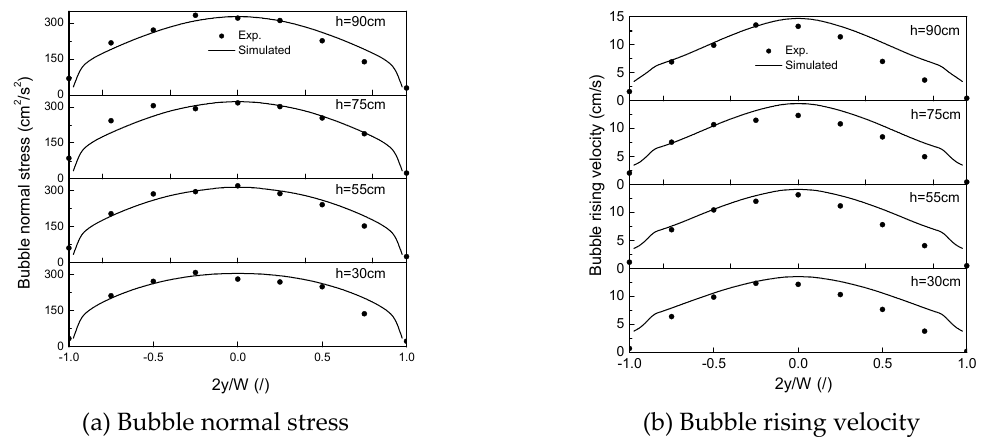
Figure 3. Experimental validation of the proposed model.